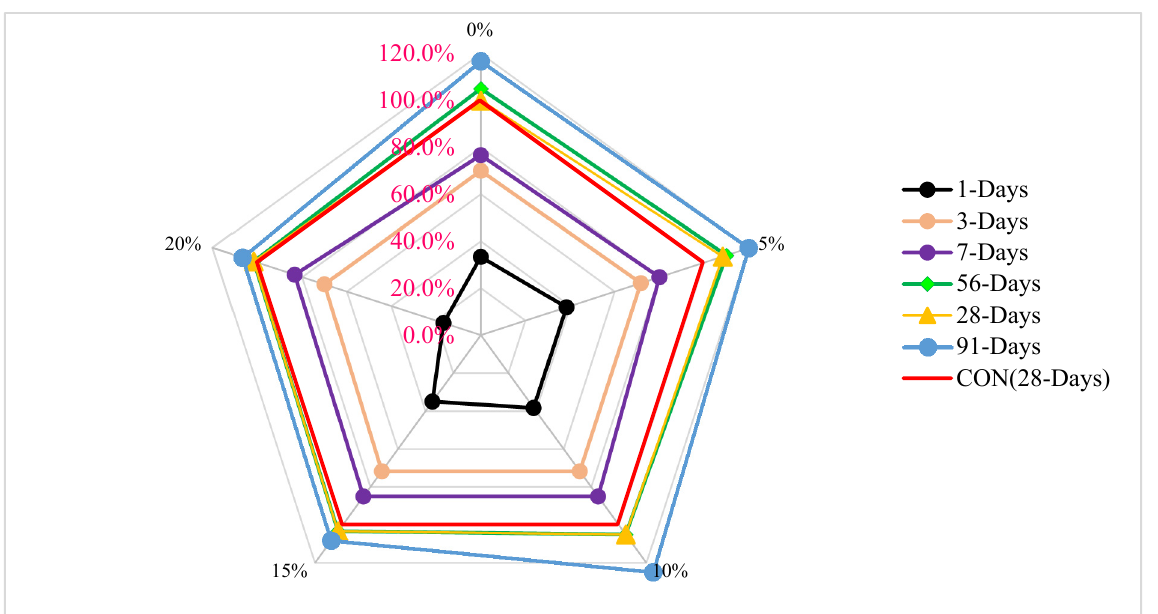
Figure 7. The compressive strength age relation of concrete with different doses of MTK: Data source [65].